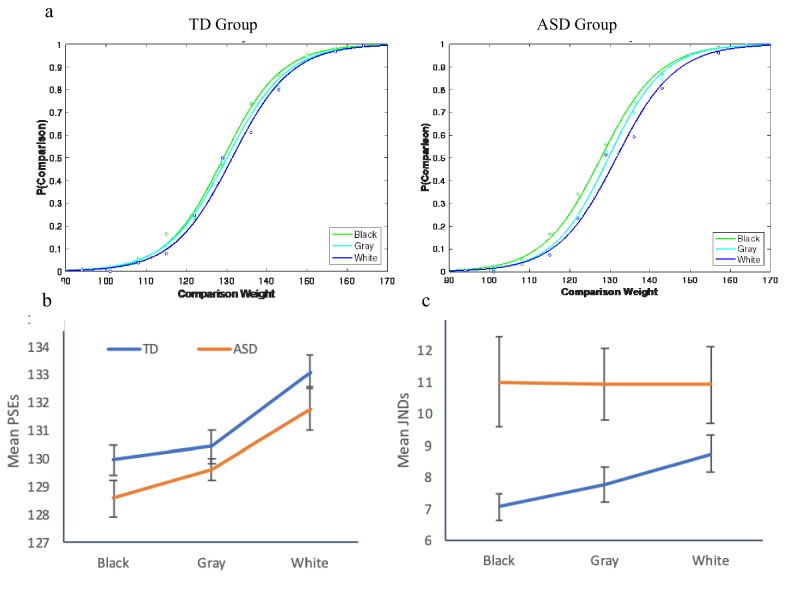
Results for Exp. 3.(a) Psychometric functions, plotting the proportion of trials for which participants reported the comparison as heavier, as a function of the brightness of the standards. Both groups were affected by the illusion, overestimating the weight of the white standard and underestimating the weight of the black standard. (b) Both groups exhibited larger PSEs for the white standard and smaller PSEs for the black standard, compared to the gray control standard. (c) Only the TD group demonstrated scaling of the JNDs to the perceived weight, in adherence to Weber’s law. Individuals with ASD exhibited constant JNDs across the perceived weights.